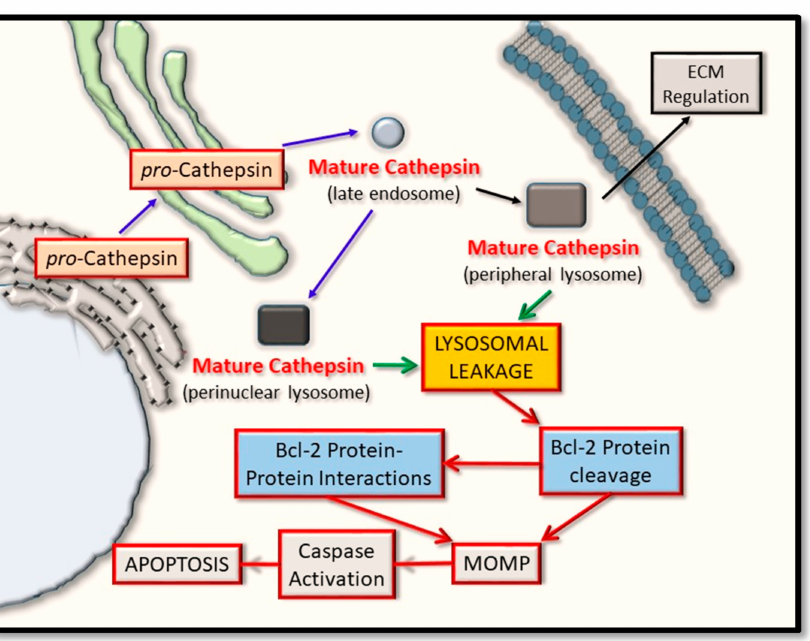
Figure 2. Cathepsin protein trafficking and intrinsic pathway activation for apoptosis. Cathepsin proteases are synthesized in their pro-inactive forms and mature through pro-domain removal, as they take on an endosomal and lysosomal localization. Through lysosomal leakage, they are released into the cytoplasm where they have the potential to proteolytically cleave certain Bcl-2 family protein members and thus alter their ability to form oligomers. Such events converge on regulating mitochondrial outer membrane permeabilization (MOMP) and have the effect of regulating caspase activation and cellular